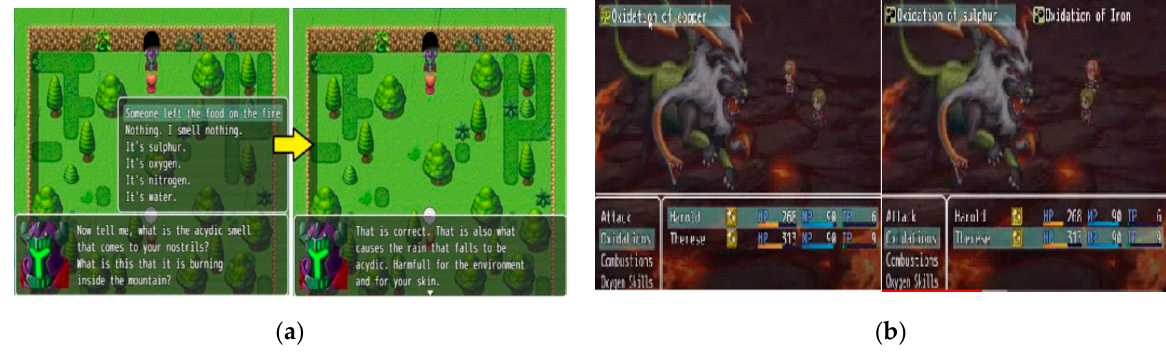
Figure 4. PCs interactions could be rather influenced by the adventure and the RPG genres. ( a ) The PCs need to answer a riddle and open the entrance to the next map (Adventure Games) ( b ) two PCs combine their unique skills on oxidations to eliminate the enemy (RPGs).